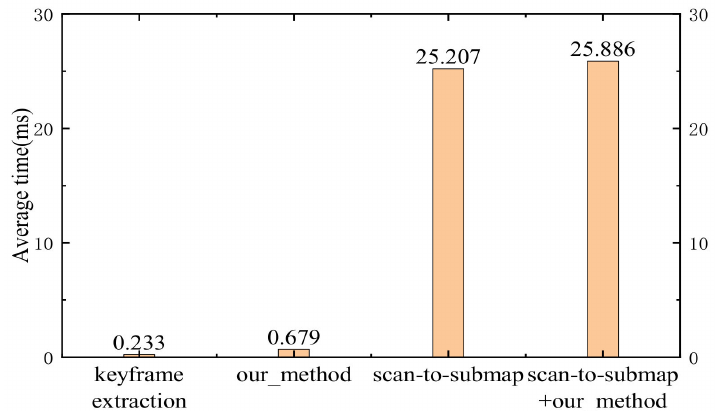
Figure 10. In the Cartographer algorithm, the time consumed comparison between the keyframe extraction method, our method, and the scan-to-submap method in processing a frame of data.